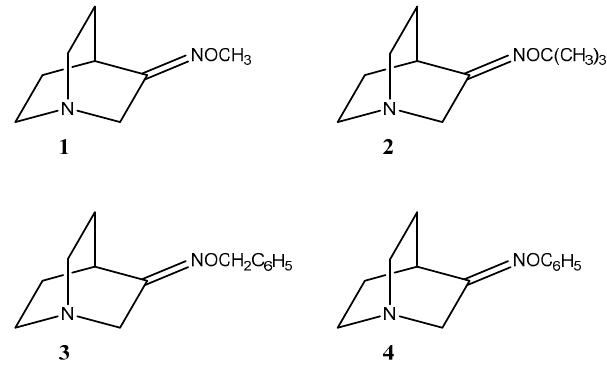
Figure 2. Synthesized O -substituted quinuclidin-3-one oximes 1 – 4 .